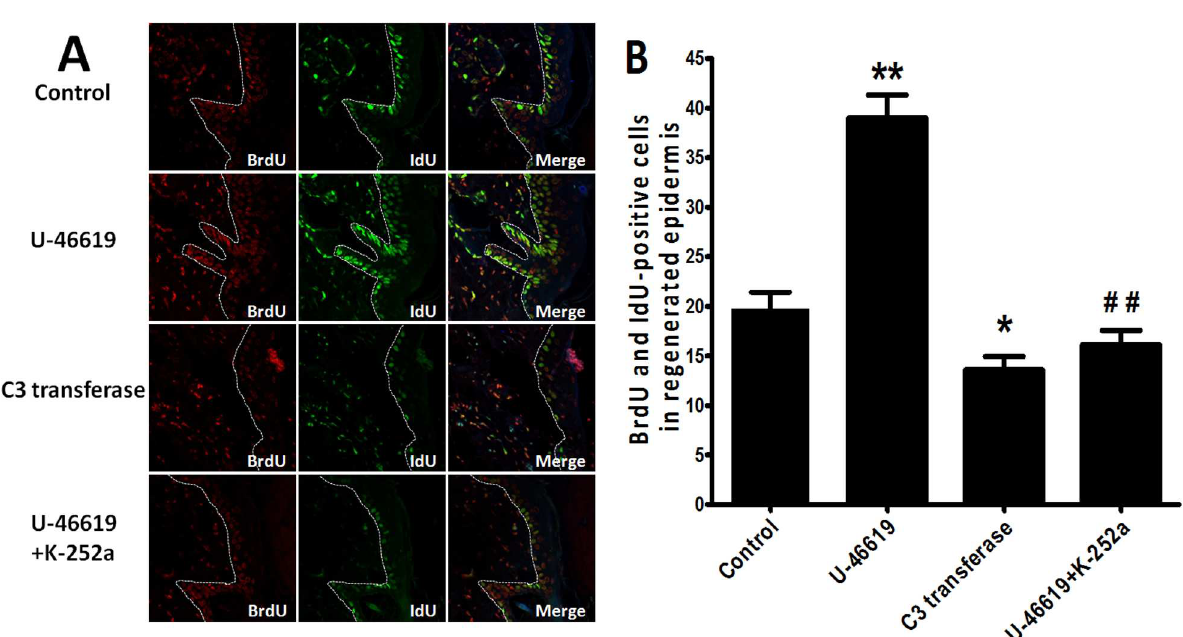
Fig 6. Immunohistochemical analysis of BrdU + IdU + -labeled cells. After BrdU labelingof ESCs and IdU incorporation, immuno- fluorescence stainingfor BrdU and IdU was performed in mice treated with normalsaline, U-46619, C3 transferase or U-46619+K-252a (A). 400 × magnification. Double-positive cells are visible in the regenerated epidermis. Representative images of well-formed, BrdU and IdU-positive cells in the regenerated epidermis are shown at the same magnification (A). (B) Data analysiswas performed using ImagePro Plus. Columns represent the mean double-positive cell count in the regenerated epidermis. The data are presented as the mean ± SD of three independent experiments; an unpaired,two-tailedStudent’st-test were used to assess significance: * P < 0.05versus control group, ** P < 0.01versus control group, ## P < 0.01versus